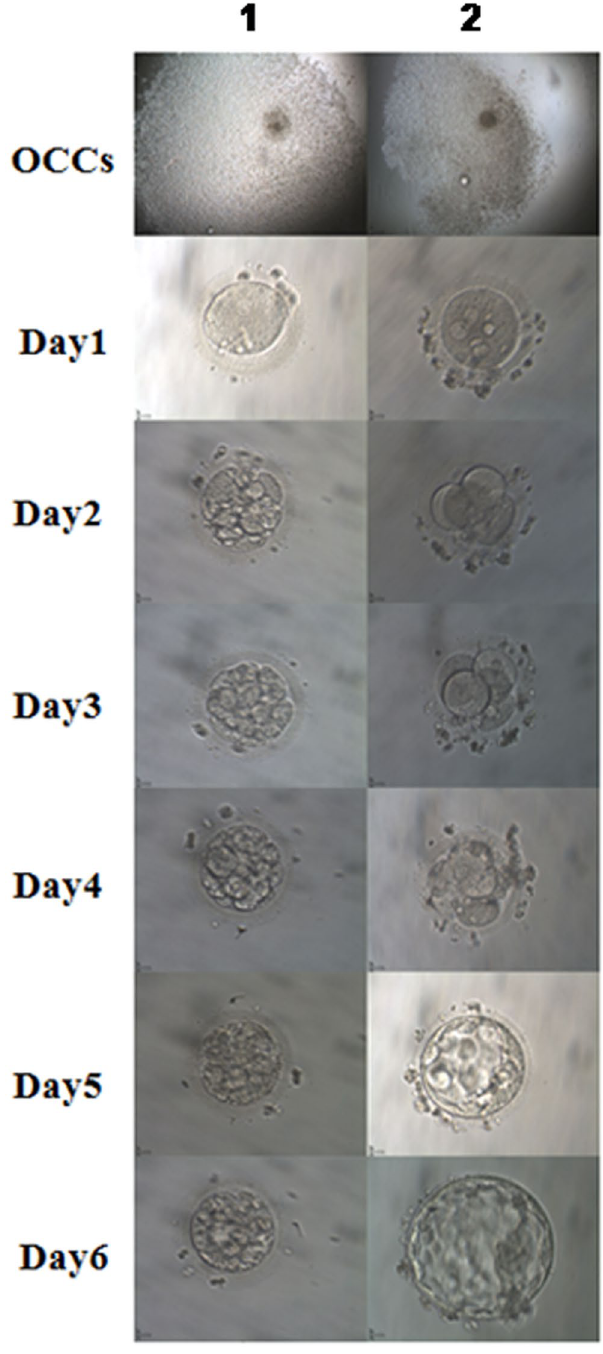
Figure 5. ICSI fertilization and embryo development.OCCCs, × 4; Oocytes, Day 1 to 6 embryos, × 20; 1, Non- blastocyst group; 2, Blastocyst